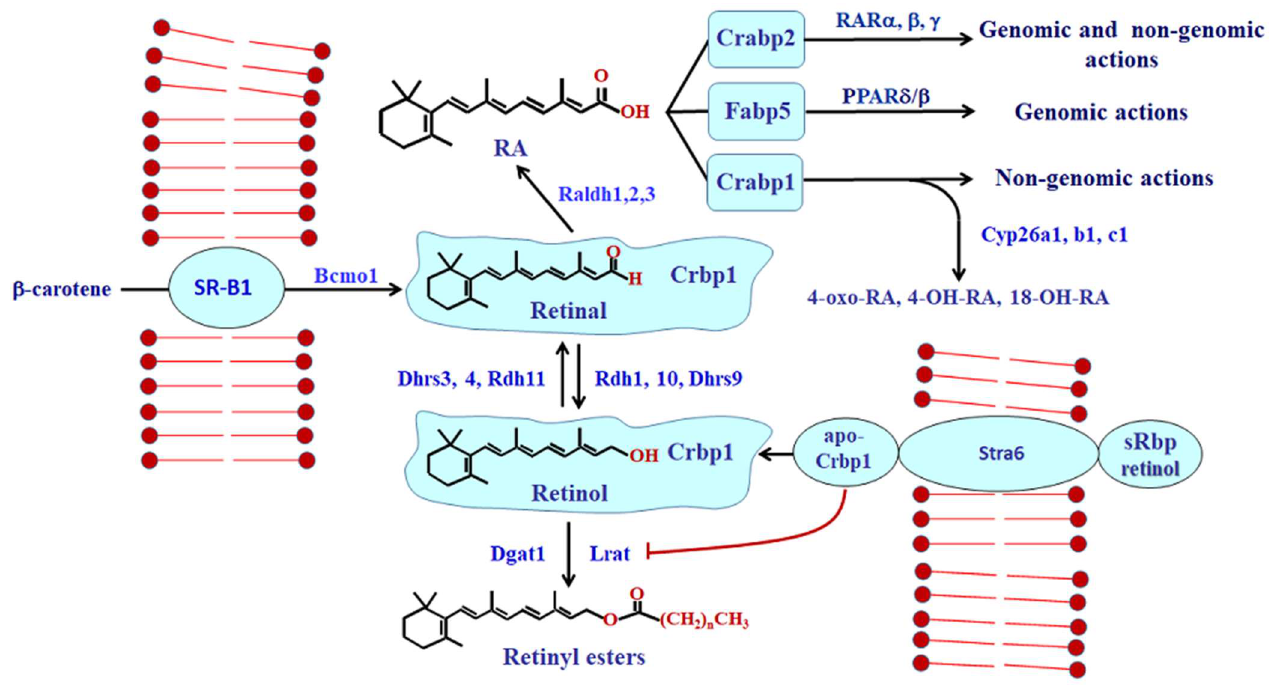
Figure 1. Model of RA